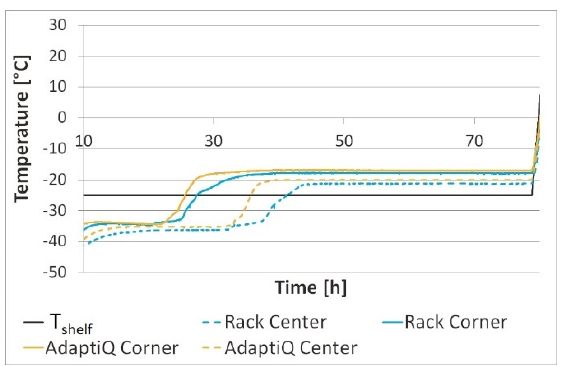
Figure 10. T P of vials in a rack and AdaptiQ nest.